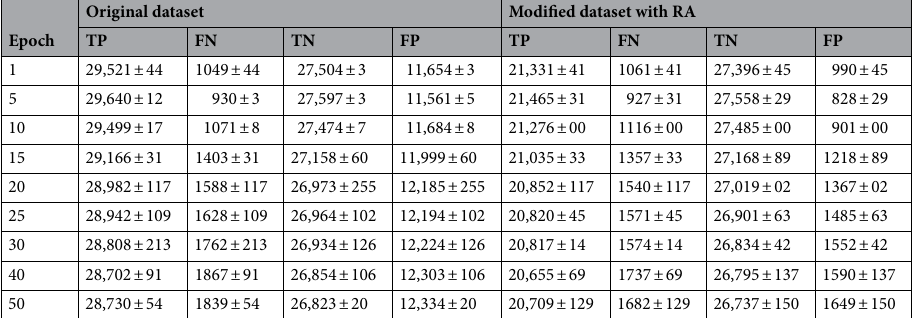
Table 7. Proposed system using original and modified datasets (with RA) (tenfold-cross validated) with epochs variations used for bleeding deep learning features depicting TP, TN, FP and FN counts k -NN classifier with k = 1 for BraTS-2021 dataset (with RA) based on deep learning